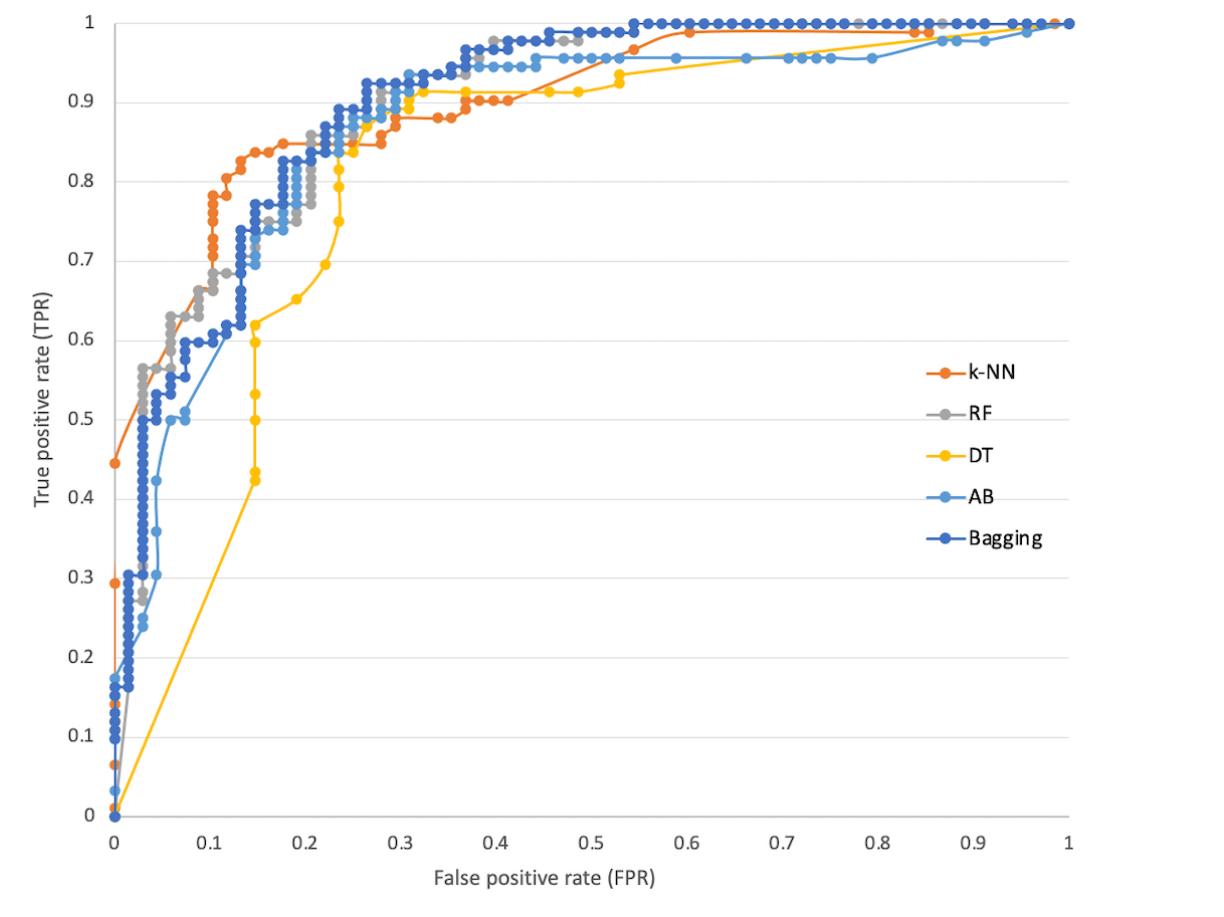
Figure 4. Receiver operating characteristic curves of all classifiers based on enriched data. AB: AdaBoost; DT: decision tree; k-NN: k-nearest neighbor; RF: random